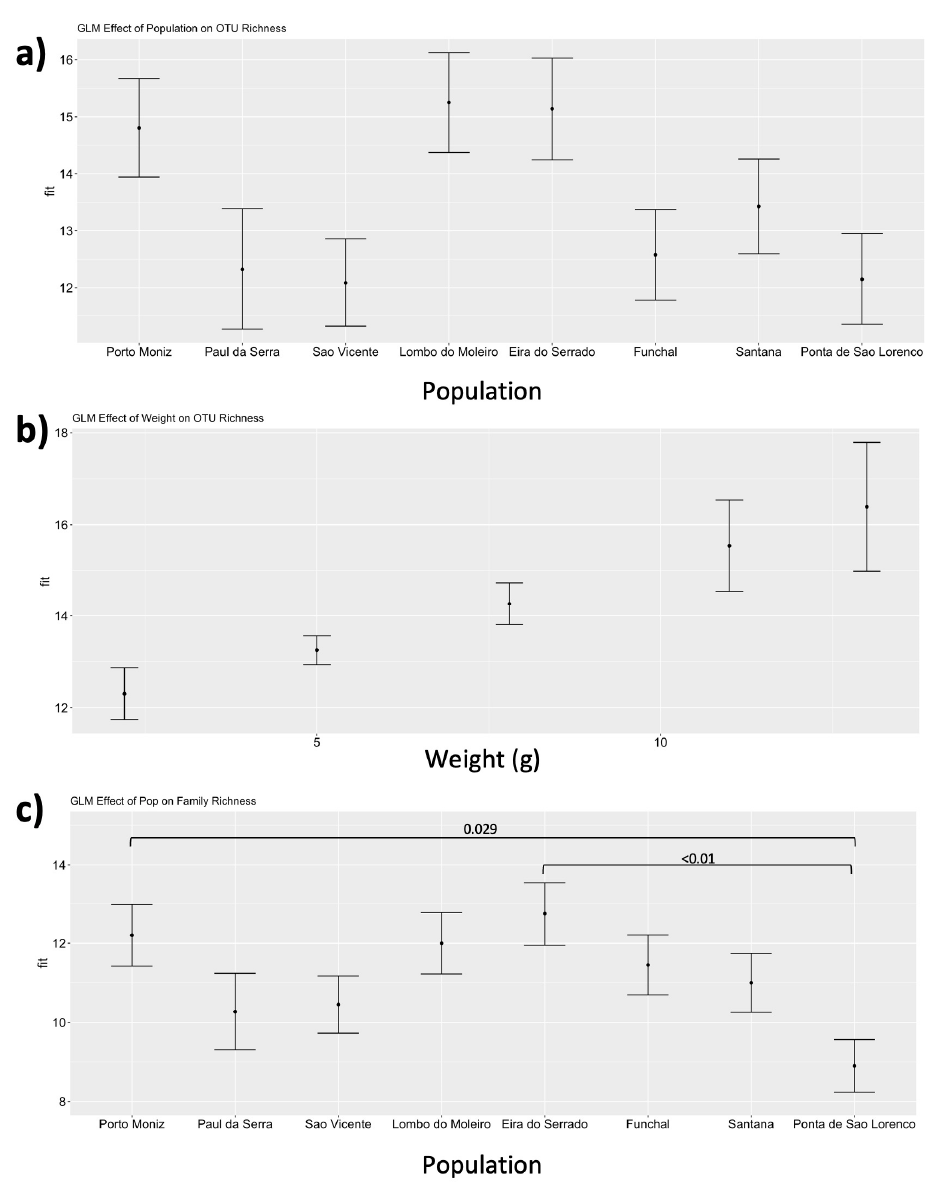
Figure 3. Graphical representation of the General Linear Models results denoting the statistically significant relationships between population, and weight with OTU richness ( a , b ), and population towards family richness ( c ). Regarding the latter, the p -values of the significant pairwise relationships between populations, are depicted. The y-axis represents the fitted values of the model, i.e., the sum of the estimated fixed effect coefficient and the predicted random intercept (see text for exact p -values).